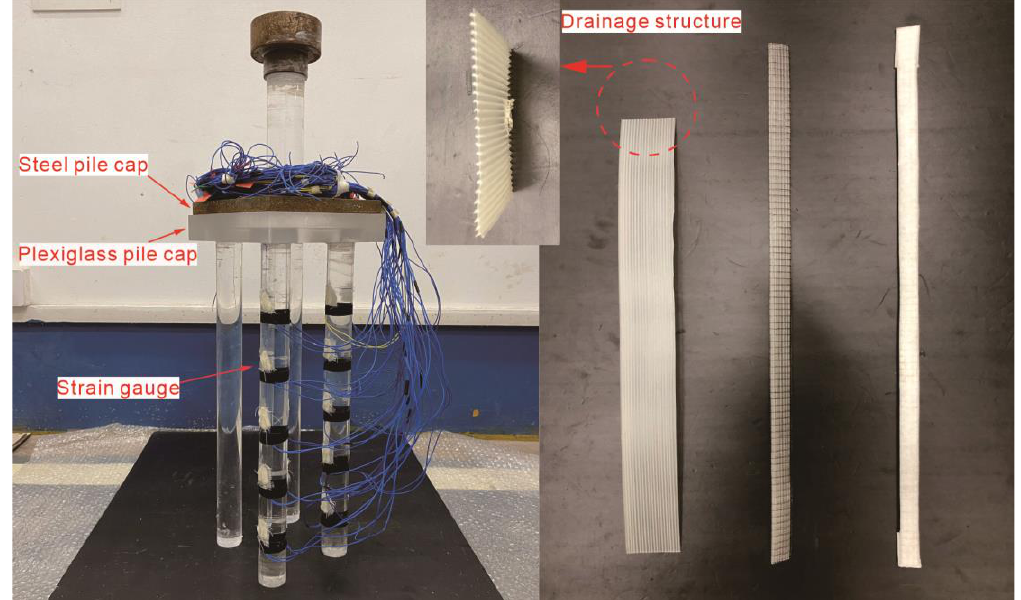
Figure 2. Annotated photographs of bridge foundation model.